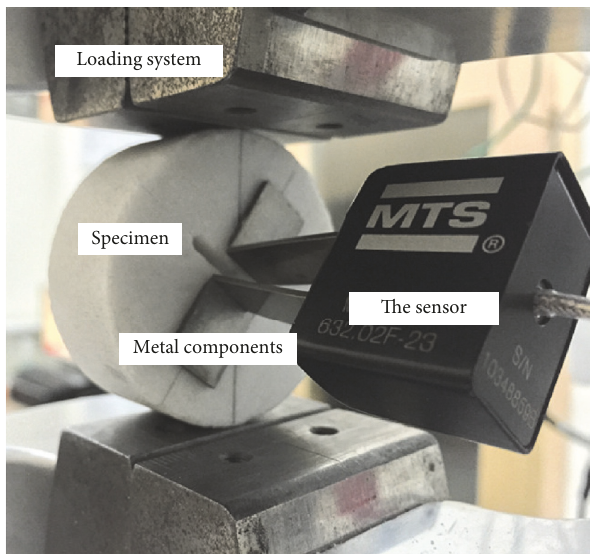
Figure 4: Crack opening displacement extensometer device: metal components and a